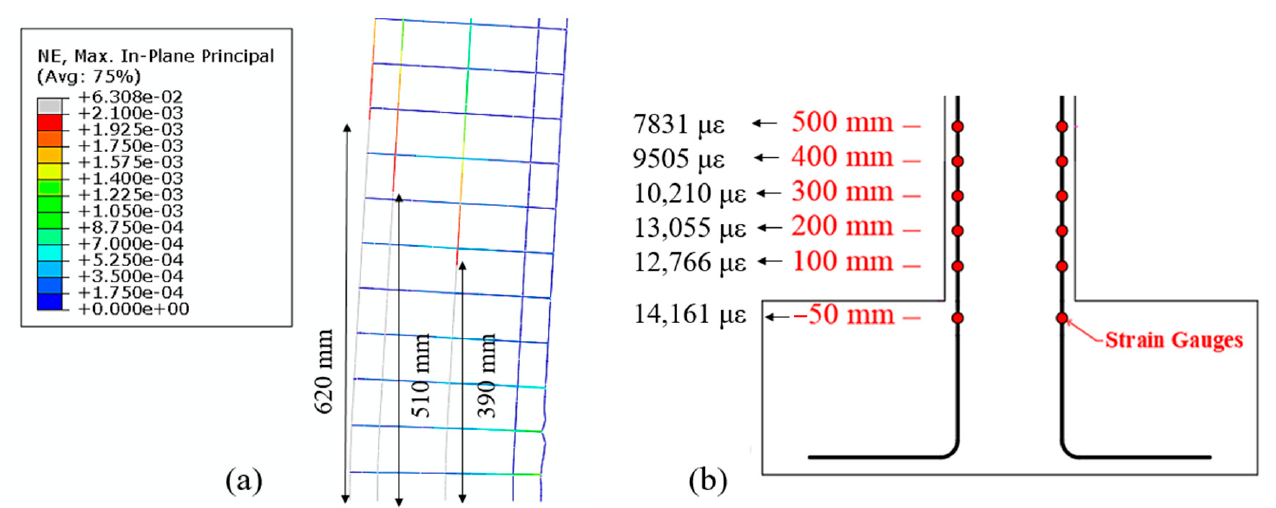
Figure 15. ( a ) Nominal strain from the FE model. Gray color in the legend indicates a strain larger than 2100 µ ε , which is assumed to be the yield strain of steel. ( b ) Recorded strain obtained from strain gages in the vertical rebar. Finally, the depth of spalling in the finite element model is compared with the experi- ment in Figure 16. A reasonable agreement is observed between the experiment and the computer simulation.